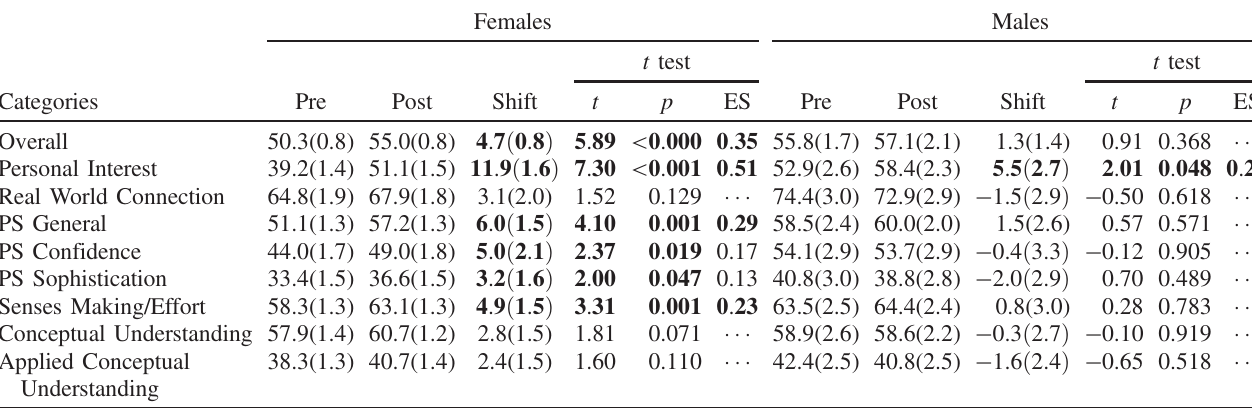
TABLE V. Pre- and postinstruction differences in individual categories ( (cid:2) standard error) in the PI group. Bold font represents significant differences ( p < 0 . 05 ). Paired sample t tests ( t statistics, p values, and effect sizes — ES) are